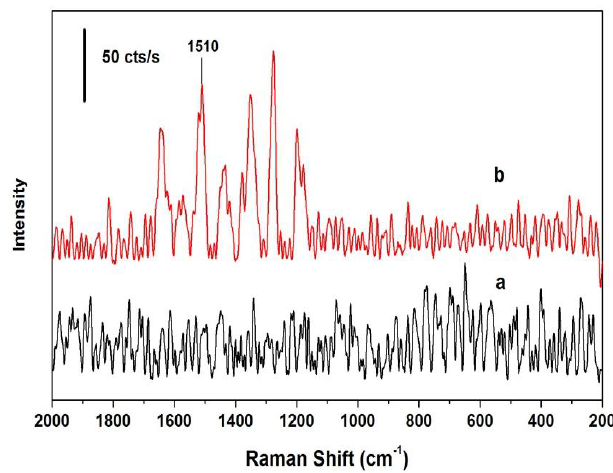
Figure 7. Raman spectra of the mixture of Fe 3 O 4 /Au–AOA and AOA–RhB ( a ) in the absence of melamine and ( b ) in the presence of 1.0 µg/mL of melamine.